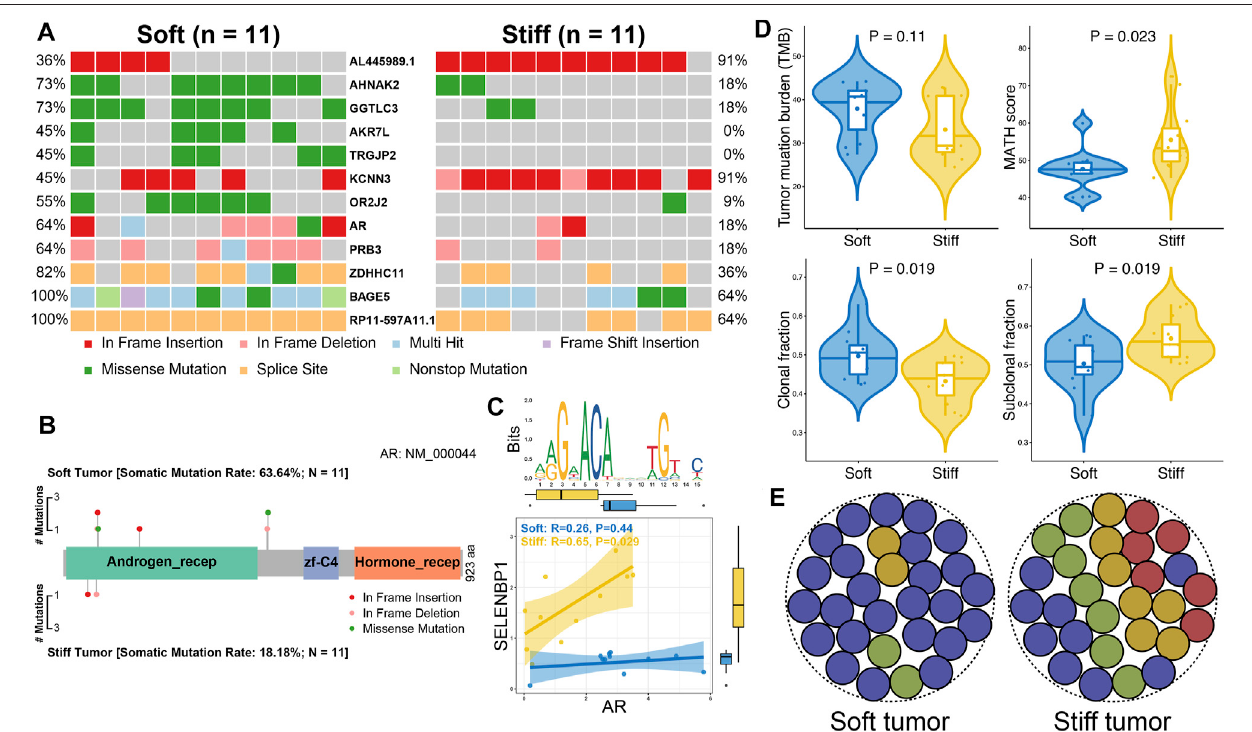
FIGURE5| Comparisonsofsomaticvariationsbetweensoftandstifftumors. (A) Waterfallplotsshowingthemutationtypesandfrequenciesof12DMGsbetween soft and stifftumors. (B) Lollipopplot illustratingthemutationsites and types ofARinsoft and stiffPAs. aa:amino acid. Androgen_recep:androgenreceptor (6-449 aa); zf-C4: zinc- fi nger, C4 type (two domains) (558-626 aa); Hormone_recep: ligand-binding domain of nuclear hormone receptor (692-877 aa). (C) Analysis of the correlation between AR and its target gene (SELENBP1) in soft and stiff PAs. An AR motif is displayed in the upper panel. (D) Comparisons of TMB, MATH score, clonal fraction, and subclonal fraction between soft and stiff tumors. (E) Schematic diagram displaying the intratumoral heterogeneity of soft and stiff PAs.